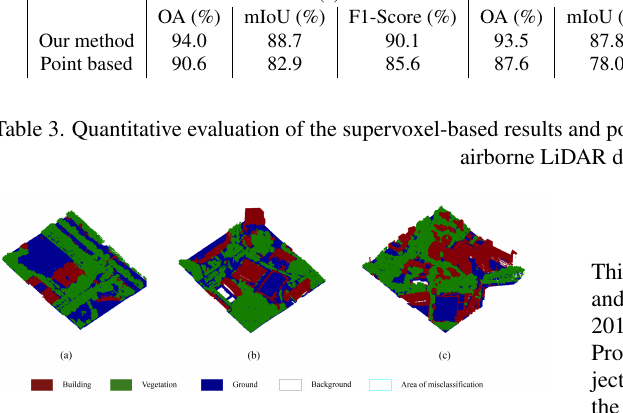
Figure 7. Classification results of airborne LiDAR-generated Shenzhen sites. Three selected sites have been marked as (a), (b) and (c).